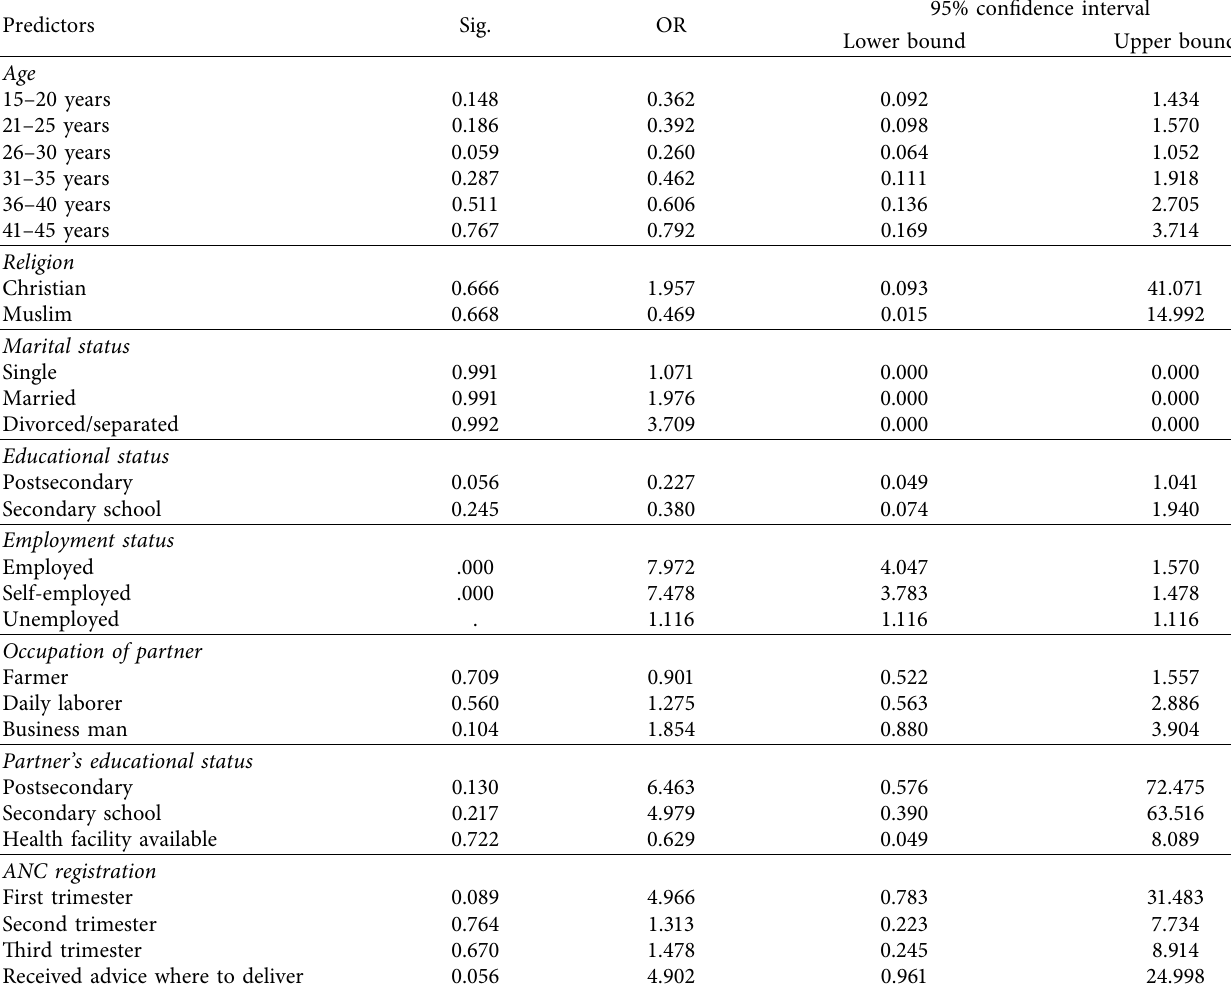
Table 3: Multiple logistic regression analysis to predict health facility